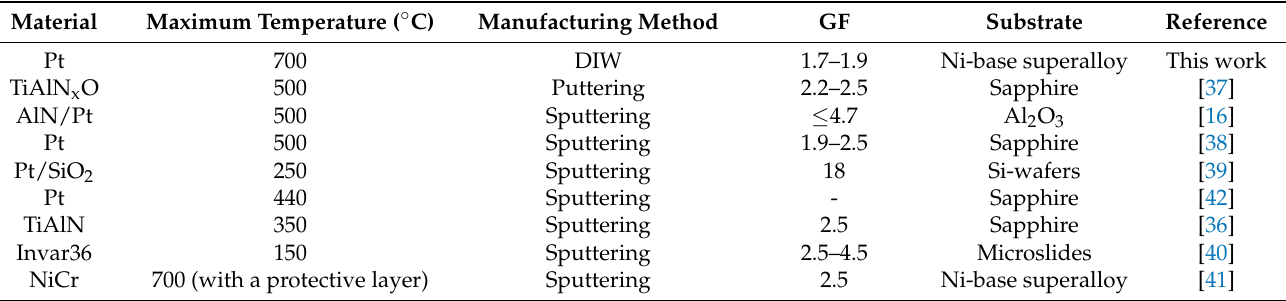
Table 1. Summary of recently released strain